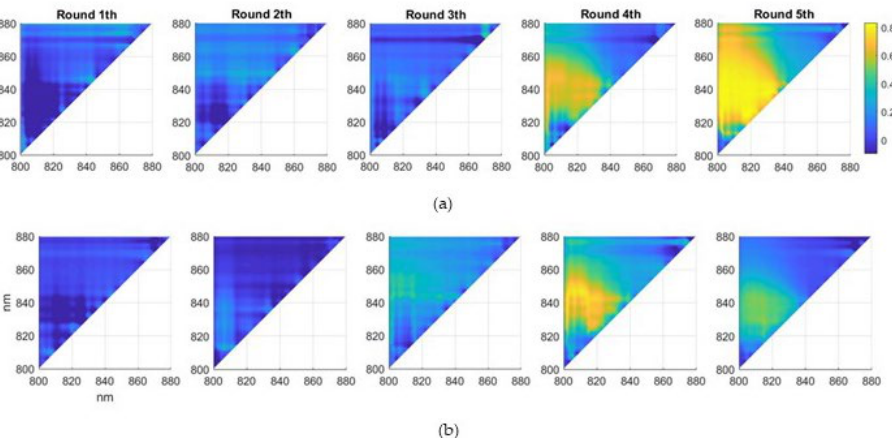
Figure 3. Maps of the correlation coefficient between MC measured at the end of the experiment (round 5), and transmittance ratios Tx/Ty based on two individual bands, computed on all combi- nations of x and y ranging over the sampled spectral interval (800–880 nm) for each round (1 to 5). ( a , b ) refer to T1 and T2 positions, respectively.